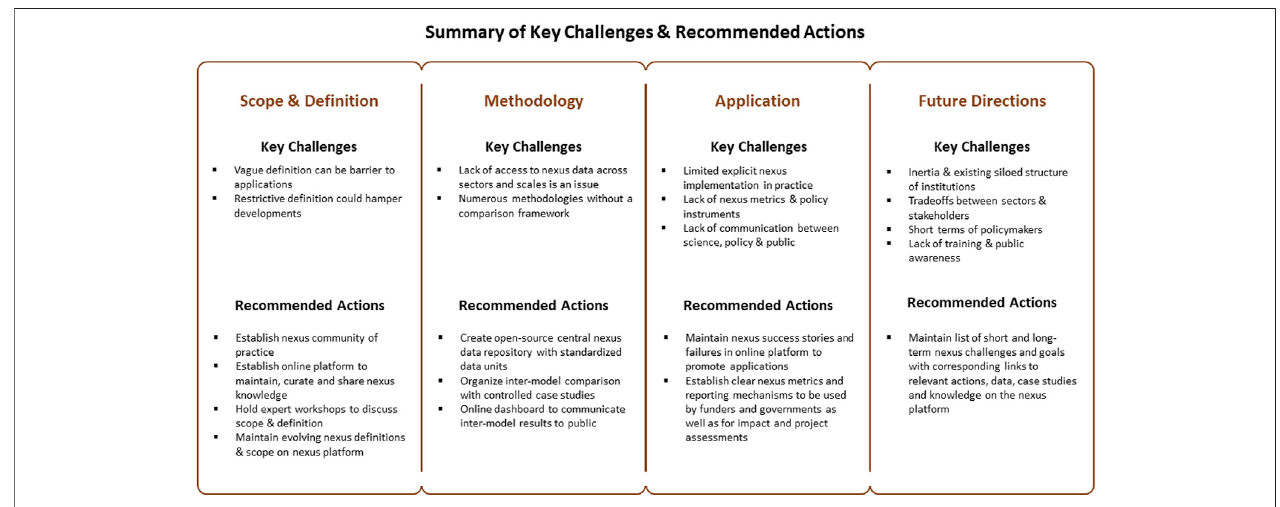
FIGURE 2 | Summary of key challenges and recommended actions based on responses from the surveys conducted for this paper.